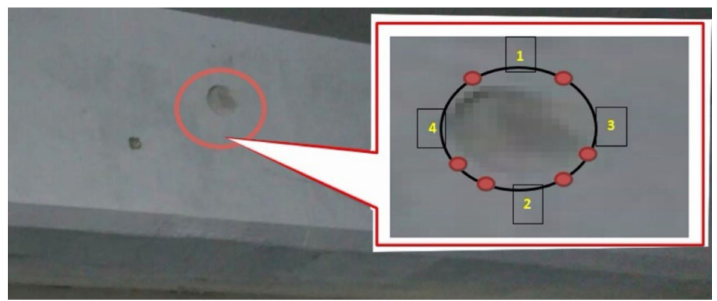
Figure 8. Test locations on the selected test